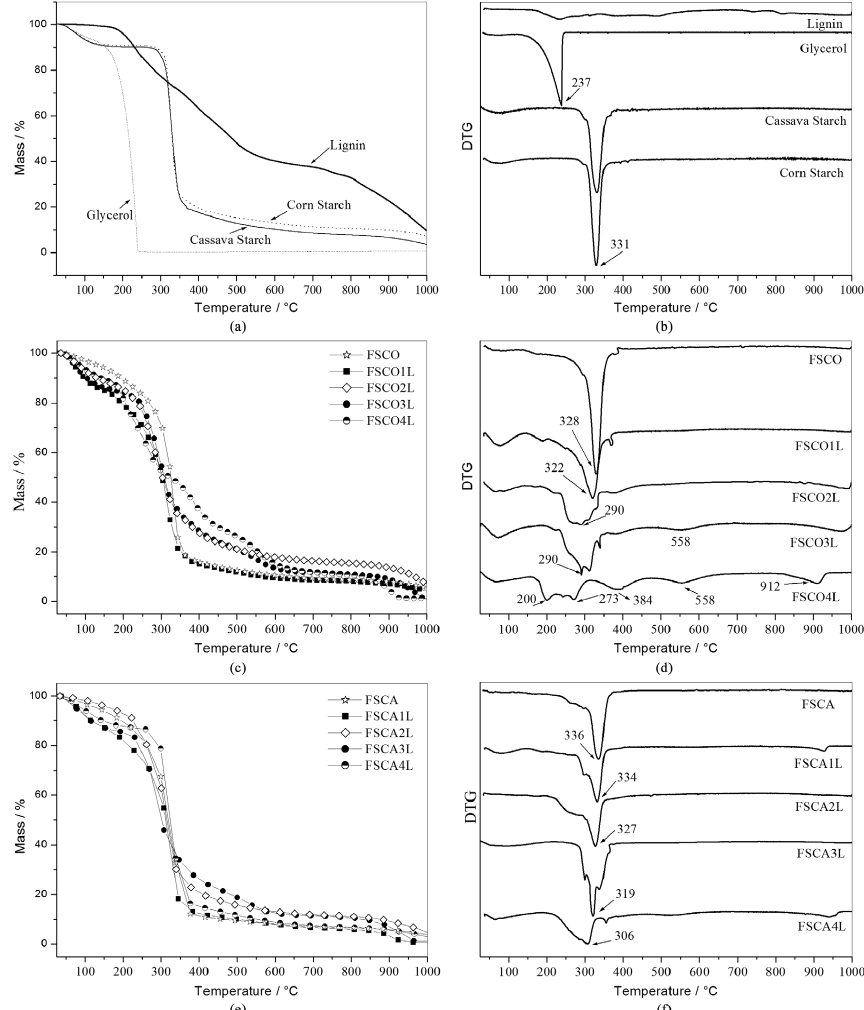
Figure 1. TGA and DTG curves of the precursors (a)/(b) the films of corn (c)/(d) and cassava (e)/(f)